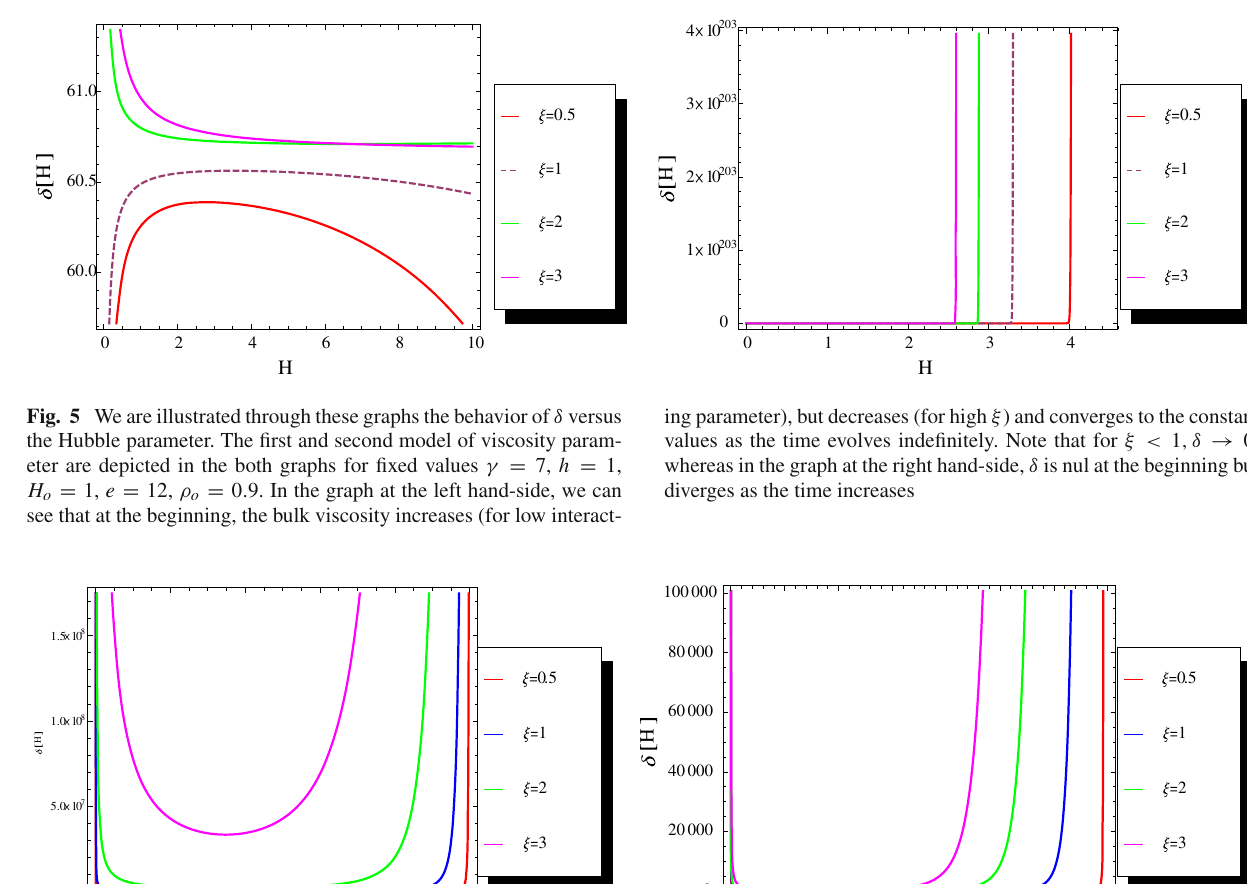
h = 2, e = 12, ρ o = 0 . 9, x r = 6, ˜ γ = 10. In these graphs, we can see that, the viscosity decreases at the beginning and becomes null as the time evolves but diverges for increasing time. Note that, the viscosity is not null for high interaction parameter